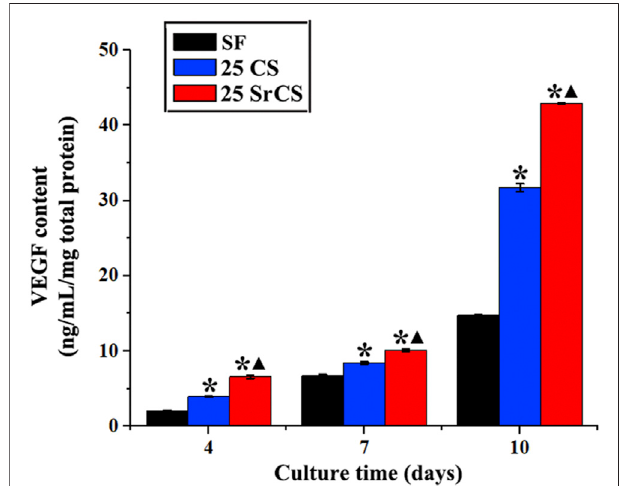
FIGURE 8 | VEGF protein content test by ELISA assay. The protein level of VEGF of rBMSCs seeded on different materials (SF: SF, CS/SF: 25 wt% CS/SF, SrCS/SF: 25 wt% SrCS/SF) for 4, 7, and 10 days. * p < 0.05 indicates the other groups vs. the SF group, and ▲ p < 0.05 indicates the 25SrCS group vs. the other